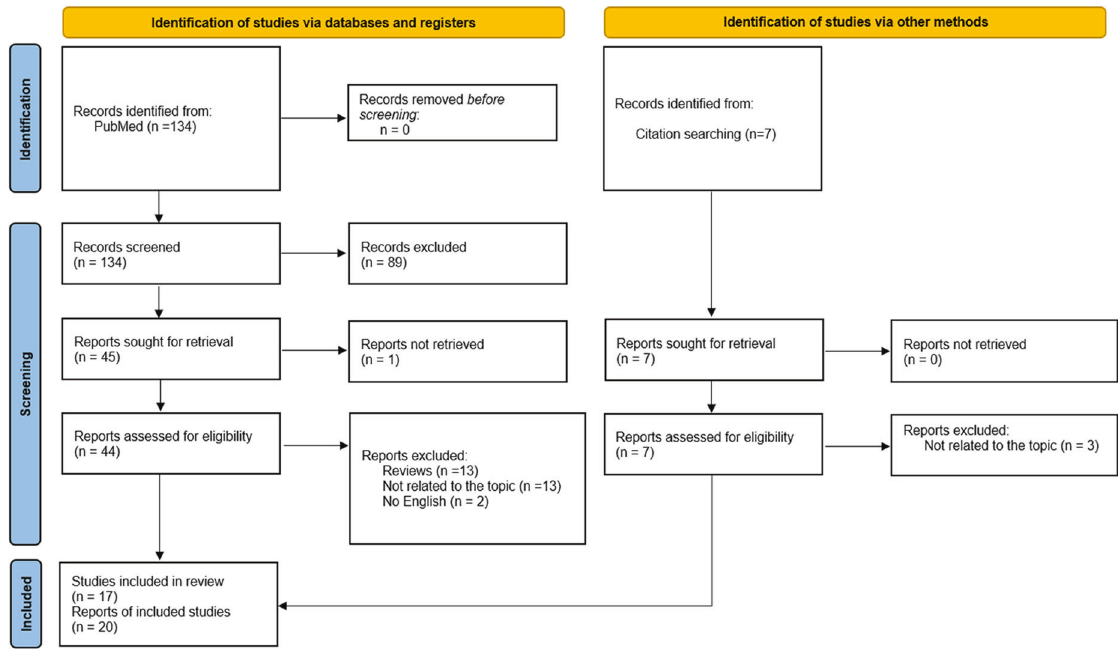
Fig. 1 Identi fi cation of studies for inclusion in systematic